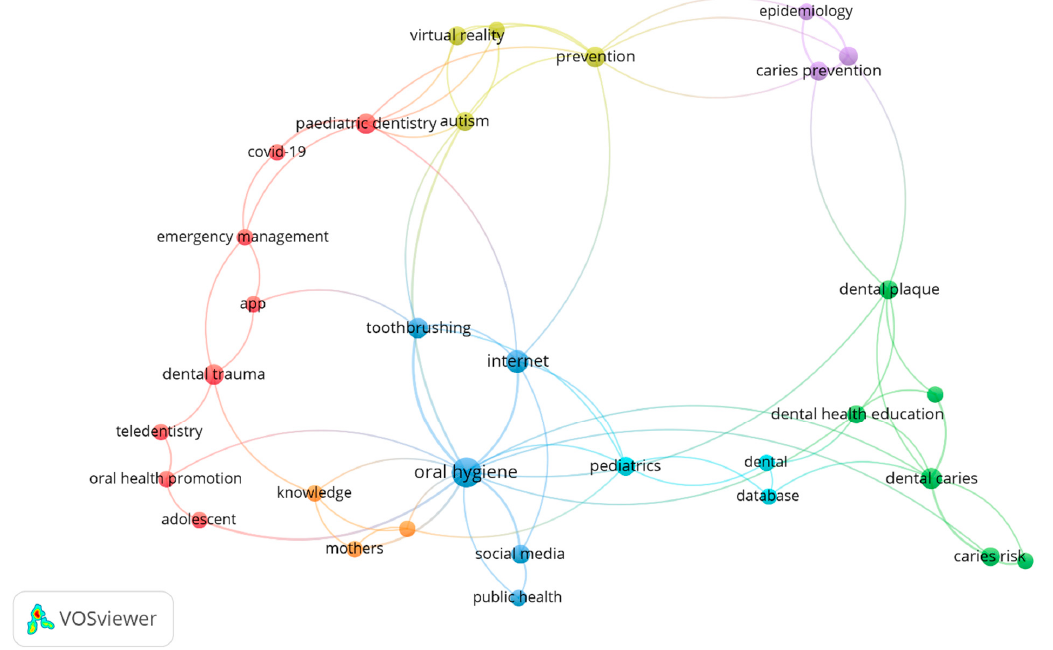
Figure 3. Network visualization map of the author keywords (keyword threshold = 2; displays 32 out of 211 keywords). Each colour represents different patterns of co-occurrences based on multiple keywords retrieved from the dataset.